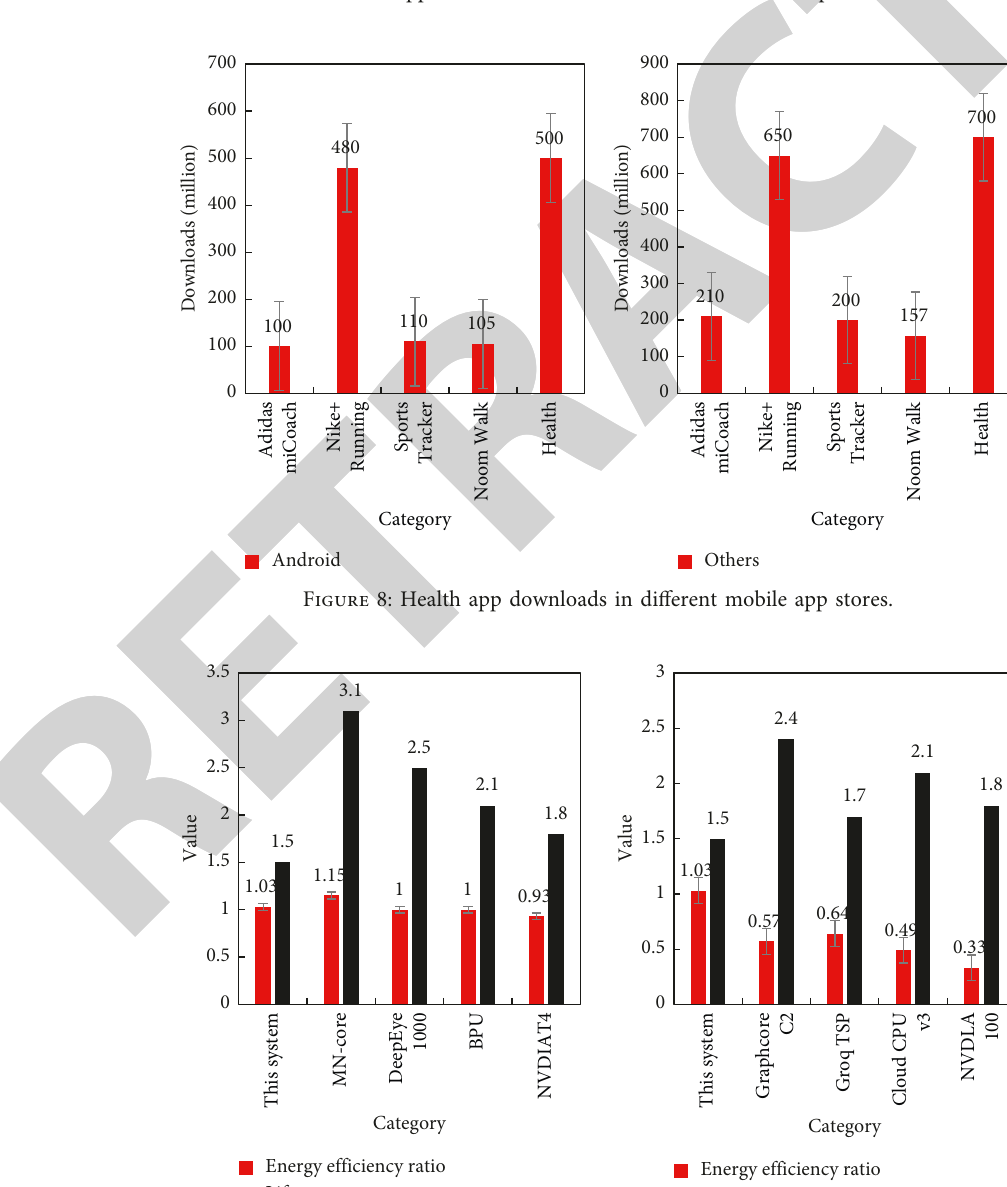
Figure 9: Comparison of energy efficiency between IoT intelligent computing system and other